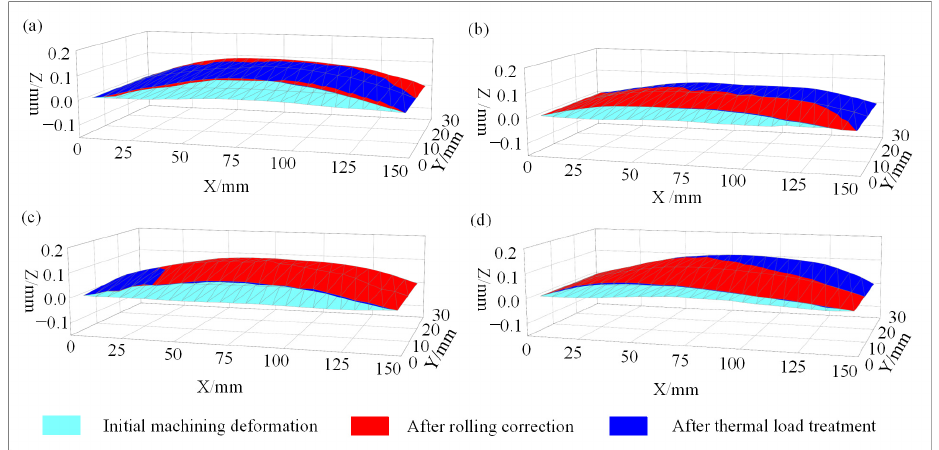
Figure 4. Macroscopic distortion diagrams of structural parts after milling, rolling correction and thermal load heat treatment: ( a ) T2/120 °C, ( b ) T3/160 °C, ( c ) T4/230 °C, and ( d ) T5/300 °C.